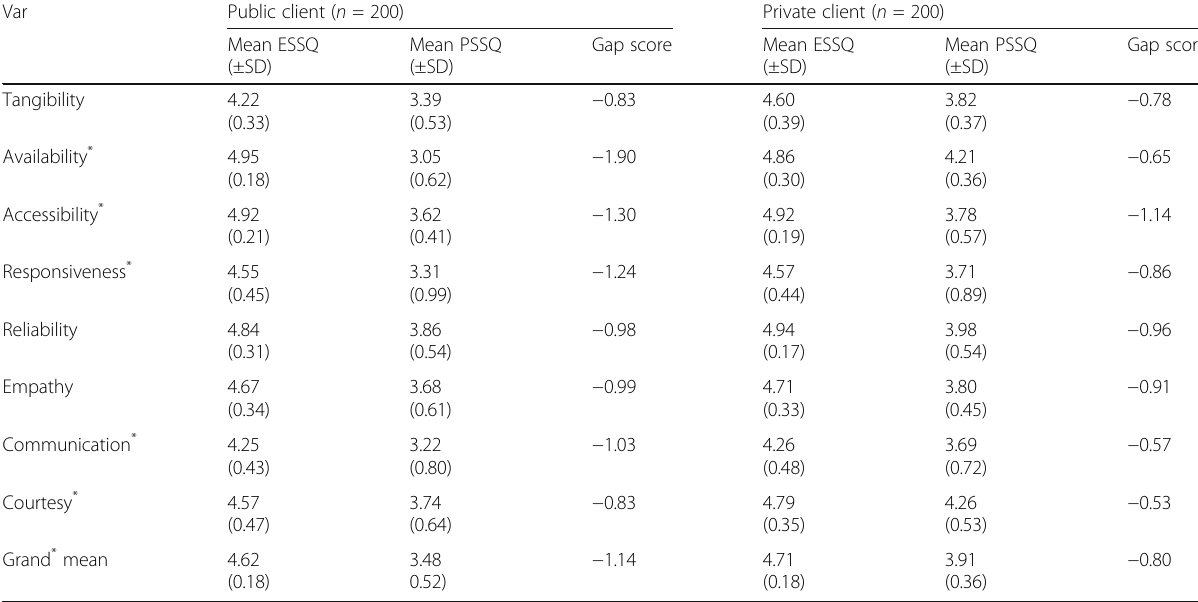
Χ 2 ; p -value; odds ratio Private n = 200 (%) n = 200 (%) ( n = 400; df =